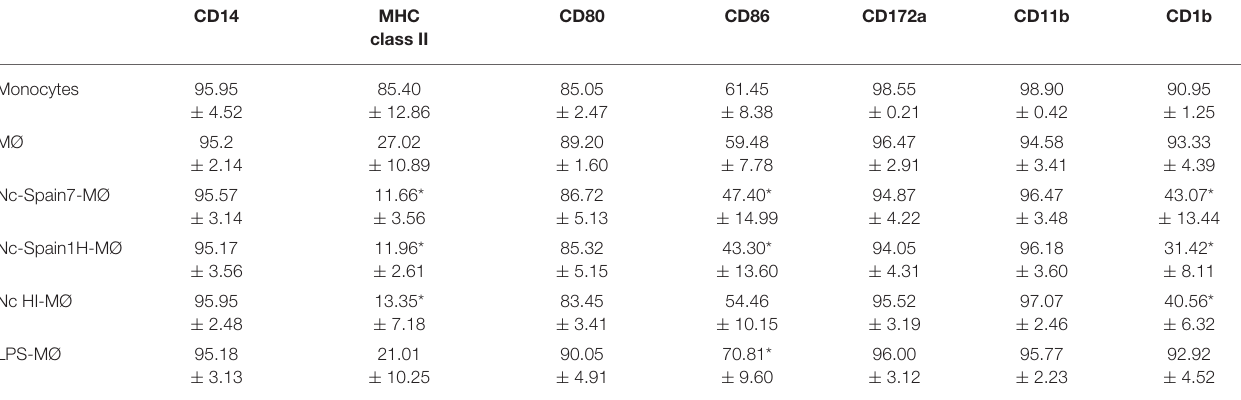
The results are expressed as the percentage of stained cells for each surface molecule in monocytes, non-infected MØs (MØ), and MØs challenged for 4h with N. caninum Nc-Spain7 (Nc-Spain7-MØ) or Nc-Spain1H (Nc-Spain1H-MØ) isolates, heat-inactivated tachyzoites (Nc HI-MØ), and 100 ng ml -1 LPS (LPS-MØ). The data are presented as the mean values ± SD of three independent experiments. ( * ) Indicates significant differences in challenged MØs vs. non-infected cells (p <